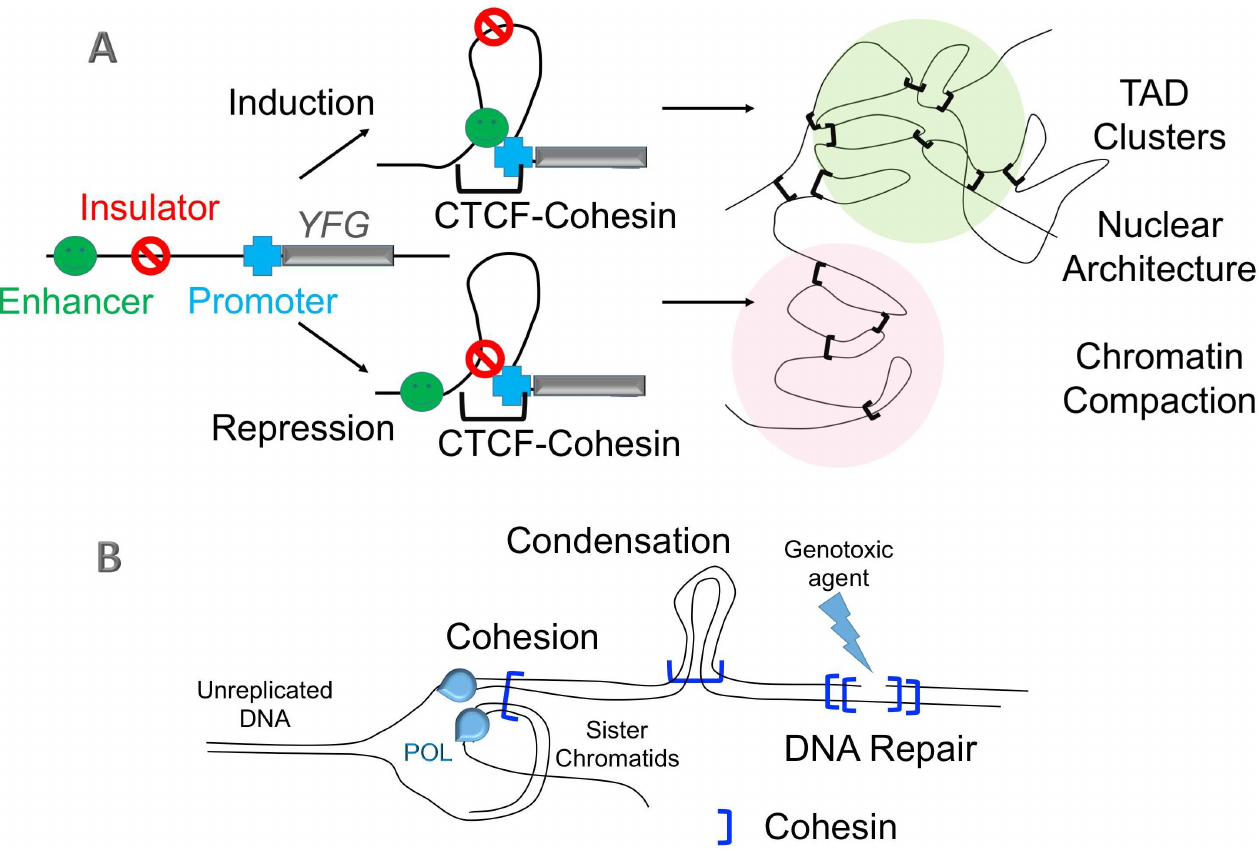
Fig 1. Cohesin functions. (A) DNA segment interactions stabilizedby CTCF (transcriptional repressor) and cohesinsdefine loopeddomainsthat aggregateinto clusters of similar transcription outputs (active or silenced), termed topologically associated domains (TADs). TAD aggregationof both cis (with a singlechromosome)and trans (involvingtwo or more chromosomes) domainsis critical for proper development and normal cell proliferation [1–3]. (B) DNA segment interactions stabilizedby cohesins(independent of CTCF) duringS phaseare critical for meiotic and mitotic sister chromatidtethering, chromosome condensation, and DNA repair